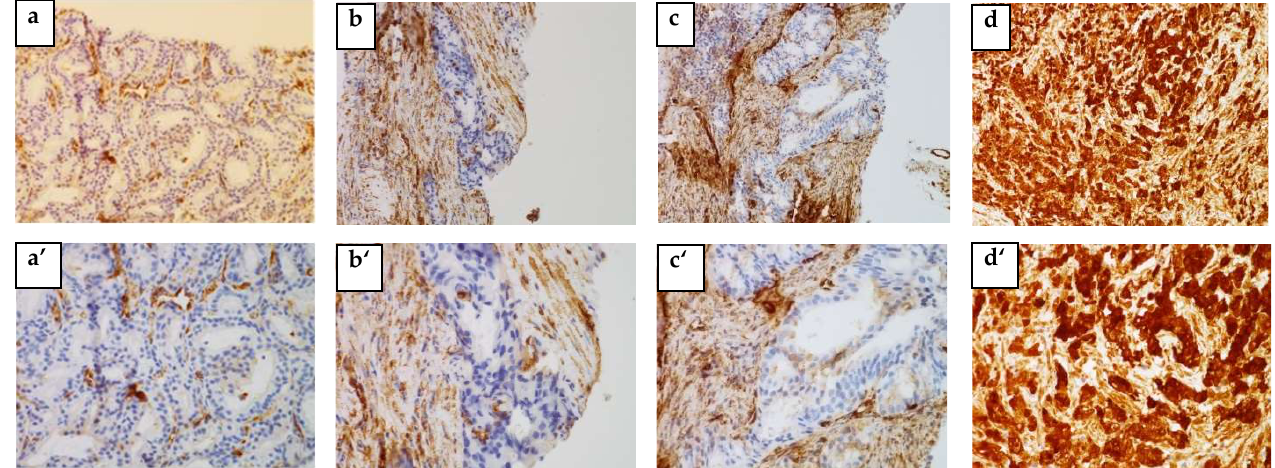
Figure 2. HSP27 expression is associated with aggressive human PCa. Representative tissue sections of PCa tumors from needle biopsies were stained for IHC specific for HSP27. ( a , a’ ) BPH, ( b , b’ ) weakly positive (non-aggressive PCa), ( c , c’ ) moderately positive (moderate PCa) and ( d , d’ ) strongly positive (aggressive PCa). ( a – d ) × 200 and ( a’ – d’ ) × 400 magnification.